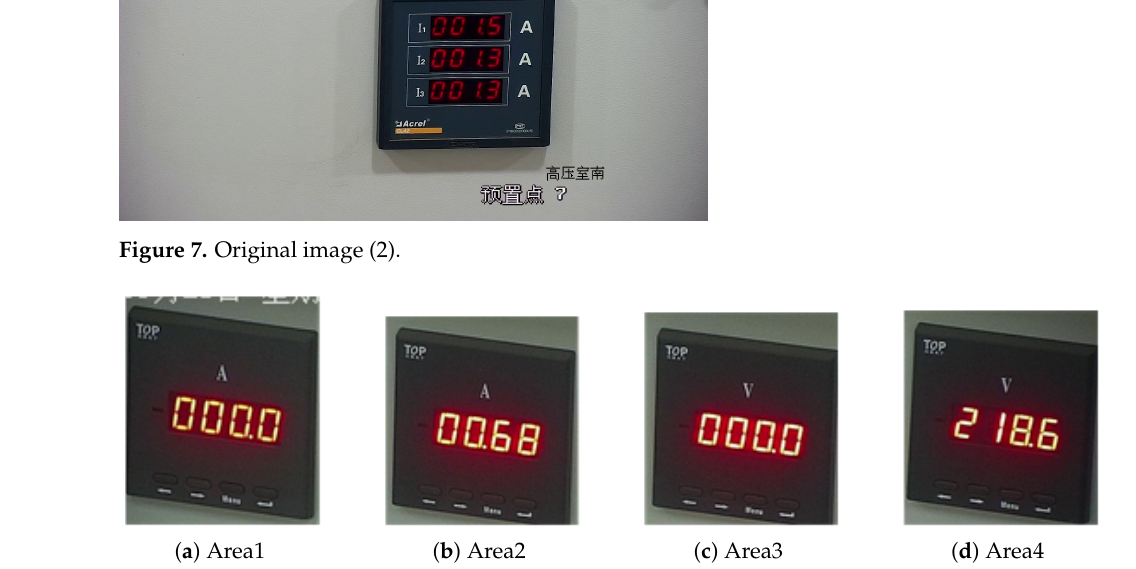
Figure 8. Locate the acquired dial area from original image (1).